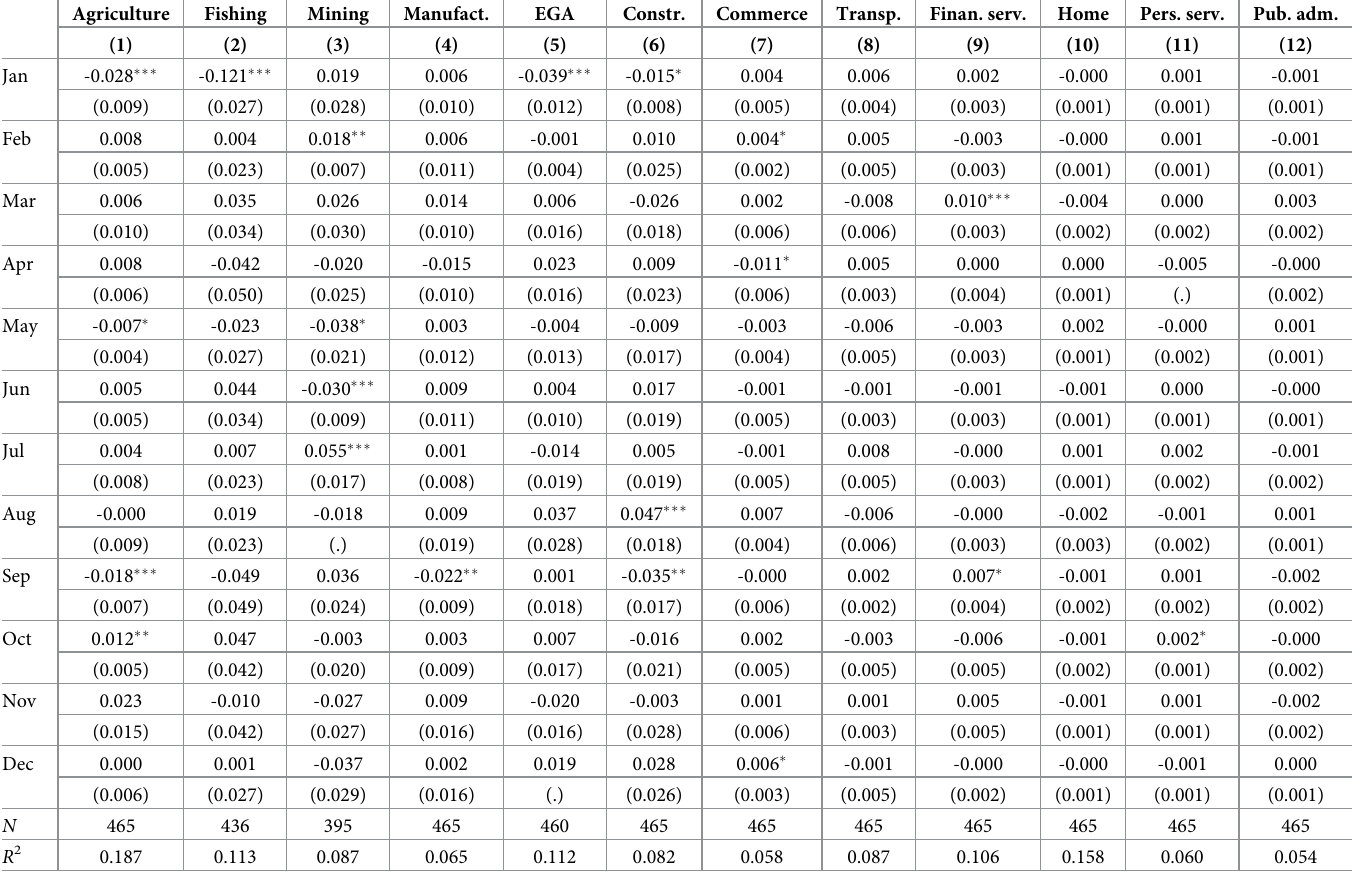
Table 5. Coefficients for the impact of temperature (monthly averages) on regional industry GDP: OLS with fixed-effects by time and region, separate regressions by industry. Agriculture Fishing Mining